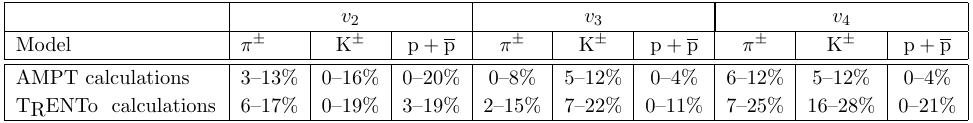
Table 3 . List of minimum and maximum values of the (cid:12)t with a constant function to relative ratios between data and each model for v n (n = 2 ; 3 ; 4) of (cid:25) (cid:6) , K (cid:6) and p + p. The percentages show deviations of the (cid:12)t from unity obtained for the 0{5% up to 40{50% centrality